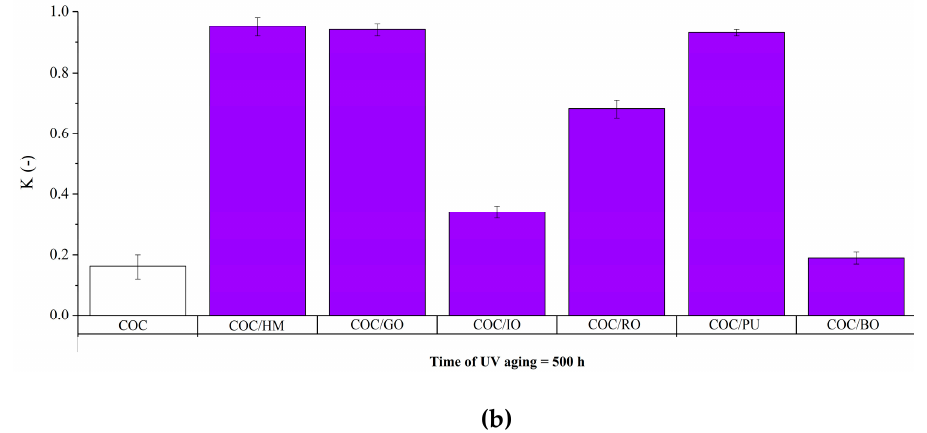
Figure 7. Aging factor (K) of the studied composites at different aging times: ( a ) 100 h; and ( b ) 500 h.